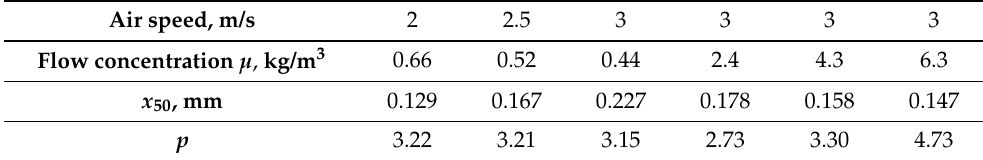
Table 1. Fine size recovery rate.